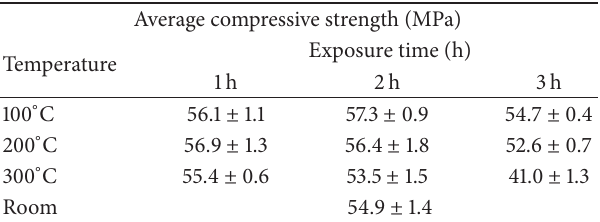
Figure 3: Specimens on the vibration machine before casting.